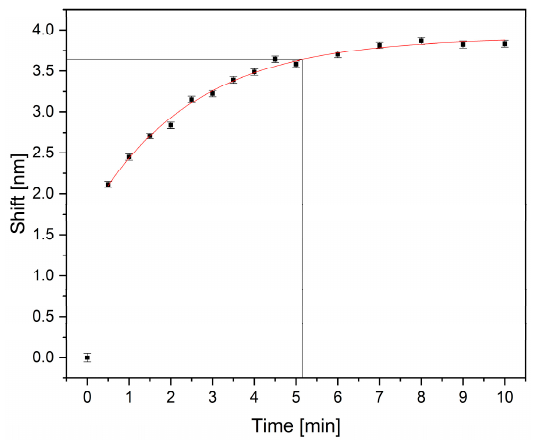
Figure 6. Time-resolved response of the sensor substrate covered with PAM hydrogel after a change from water to a 20 vol% ethanol solution.